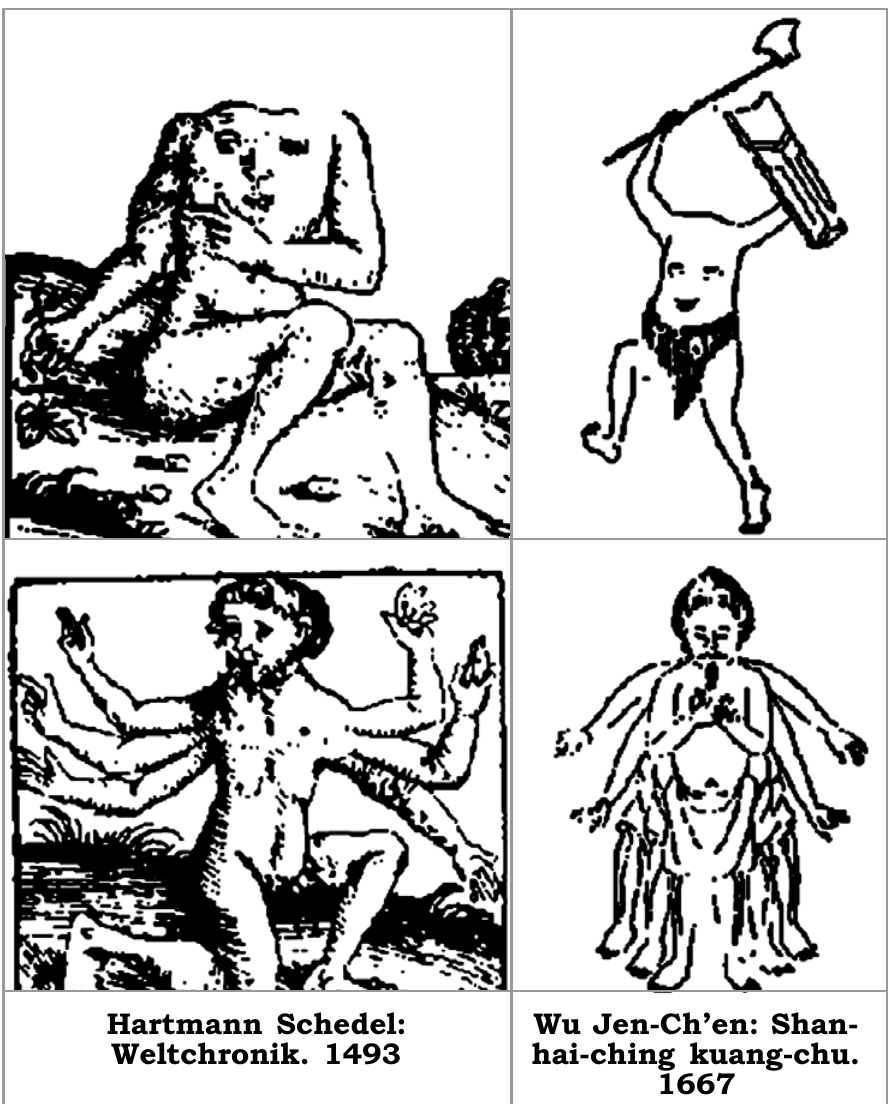
Figure 3. European and Chinese Presentation of Otherness in Early Modern History. – The strangers are monstrous, they are misshaped and lack the look of